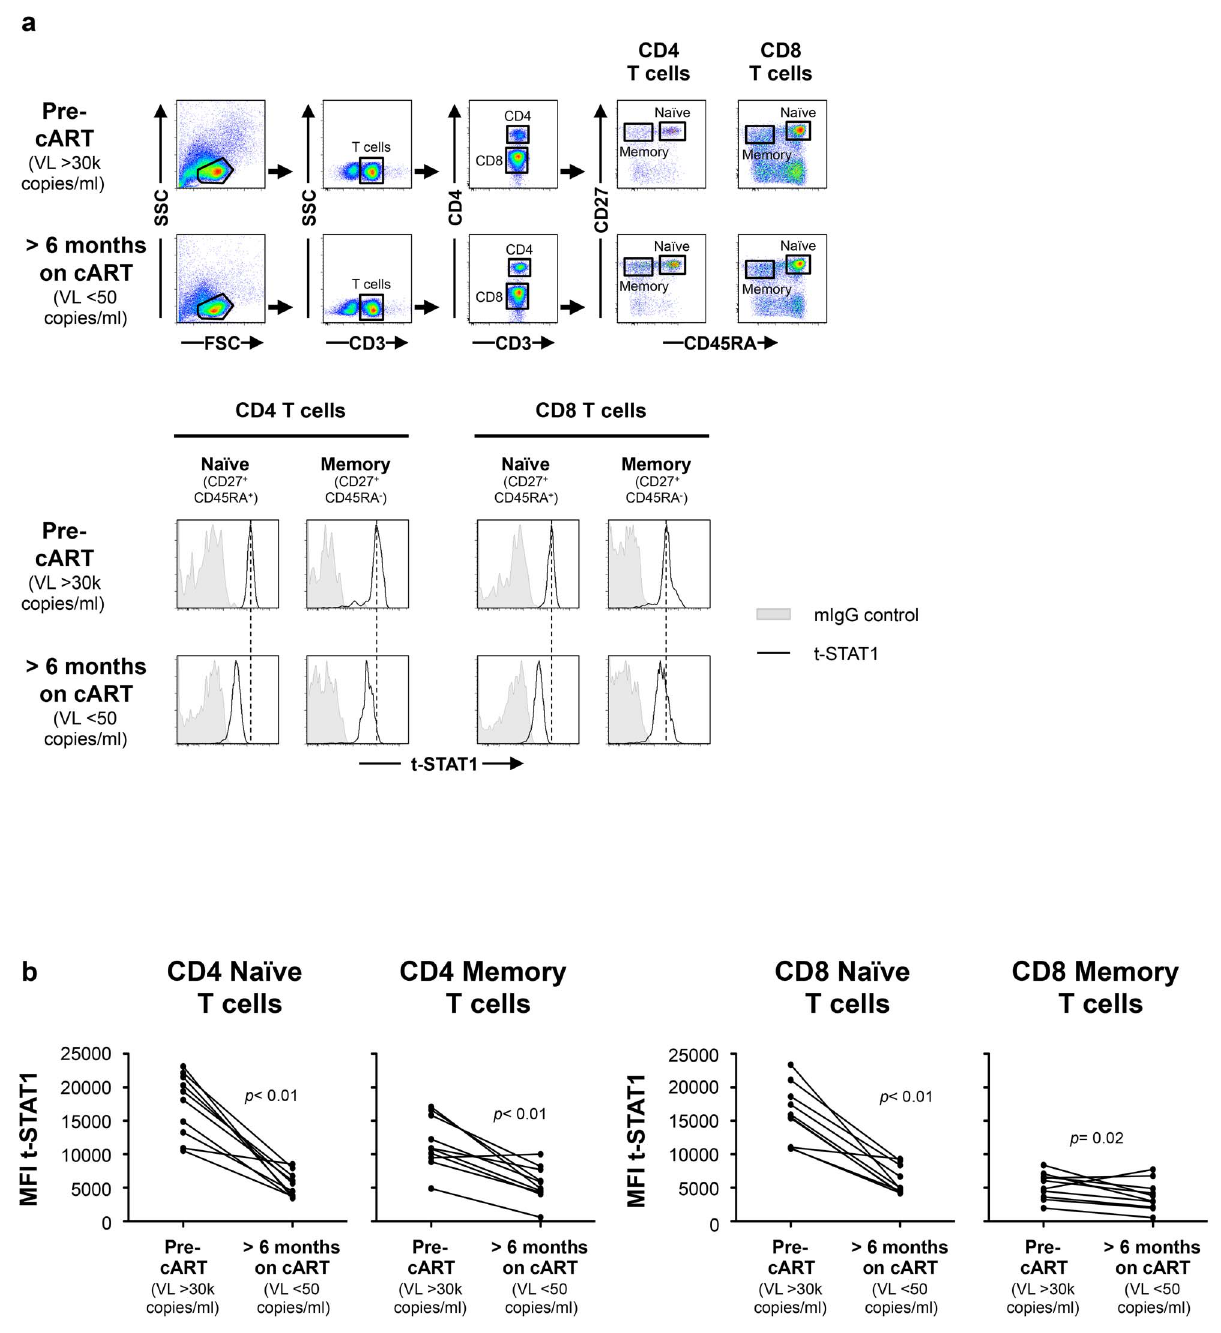
Figure 1. t-STAT1 in CD4 and CD8 T cell subsets from HIV-infected patients. PBMCs from a longitudinal cohort of HIV-infected individuals (n=10) were analyzed by flow cytometry before and after suppressing viremia to , 50 copies/ml with cART for intracellular expression of t-STAT1. ( a ) Gating strategy to assess t-STAT1 expression in T cell subsets, using CD27 and CD45RA as markers of naı¨ve (CD45RA + CD27 + ) and memory (CD45RA 2 CD27 + ) CD4 (CD3 + CD4 + ) or CD8 (CD3 + CD4 2 ) T cells. ( b ) The Median Fluorescence Intensity (MFI) of t-STAT1 in the different T cell subsets was compared before and after treatment and viremia suppressed to , 50 copies/ml using a Wilcoxon signed-rank test.